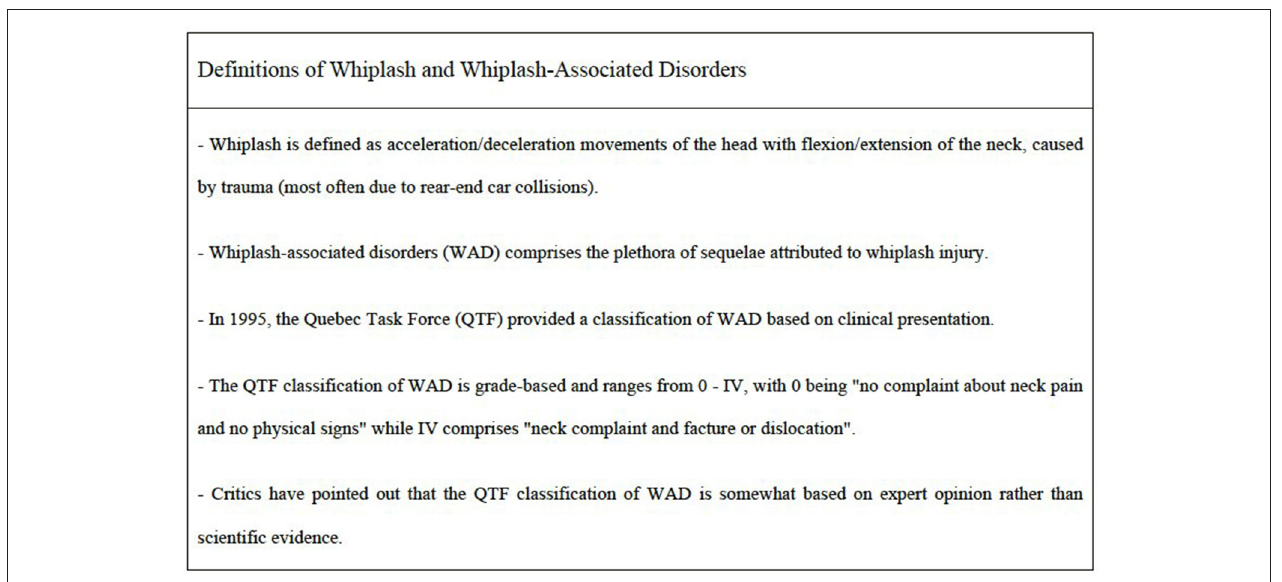
FIGURE 2 | Commonly used definitions of whiplash and WAD